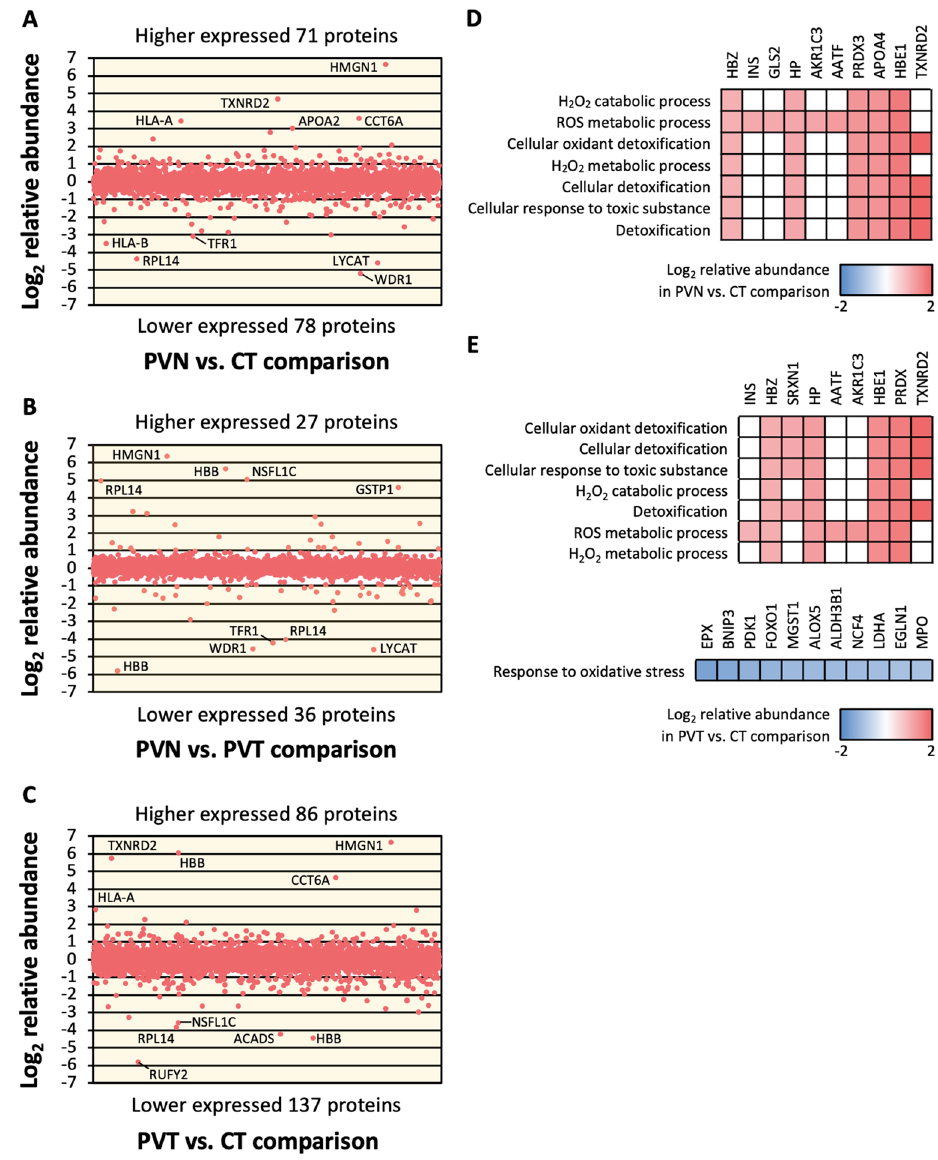
Figure 2. Proteomic analysis of erythroblasts from PV patients reveals protein expression differences. TMT labelling and nano-LC MS/MS were performed on the pooled protein samples prepared from erythroblasts on day 7 in culture. Expression levels of identified proteins were compared across CT, PVT, and PVN. Proteins differentially expressed at two or more-fold in each pairwise comparison were further entered in functional enrichment analysis. ( A – C ) Expression patterns of each protein in each pairwise comparison, yellow areas represent protein expression differences at two or more-fold, and names of the top 5 more and less abundant proteins in each comparison were labelled next to their relative abundance. The pairwise comparison shown are ( A ) PVN vs. CT comparison, ( B ) PVN vs. PVT comparison, and ( C ) PVT vs. CT comparison. ( D ) Various processes in cellular oxidant detoxification overrepresented from proteins with increased expression in PVN compared to CT, colour filling indicates proteins apportioned to biological process shown on the left. ( E ) Various processes in cellular oxidant detoxification overrepresented from proteins with increased or decreased expression in PVT compared to CT, colour filling indicates proteins apportioned to biological process shown on the